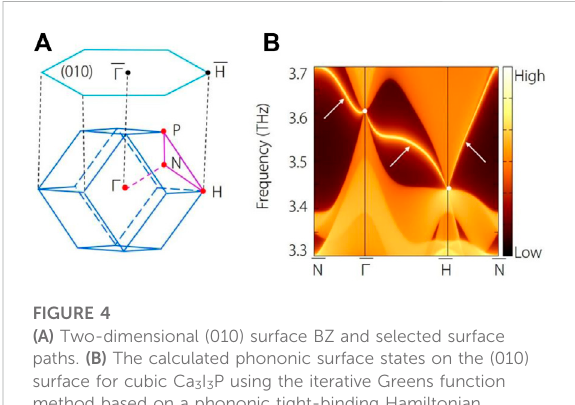
FIGURE 4 (A) Two-dimensional (010) surface BZ and selected surface paths. (B) The calculated phononic surface states on the (010) surface for cubic Ca 3 I 3 P using the iterative Greens function method based on a phononic tight-binding Hamiltonian. White arrows highlight the nontrivial surface states.